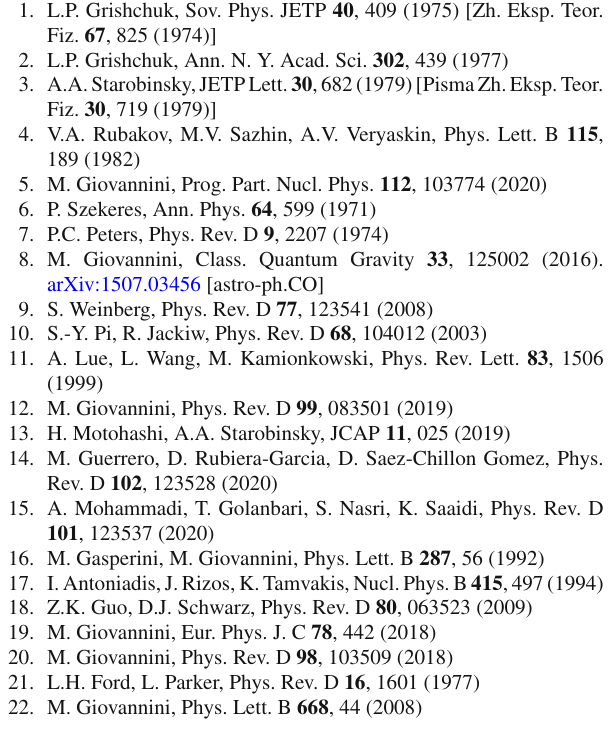
that if the PTA results are interpreted as upper limits (as originally done when introducing the variation of the refractive index [5]) the range of variation of N ∗ and α gets larger even in the minimal model examined